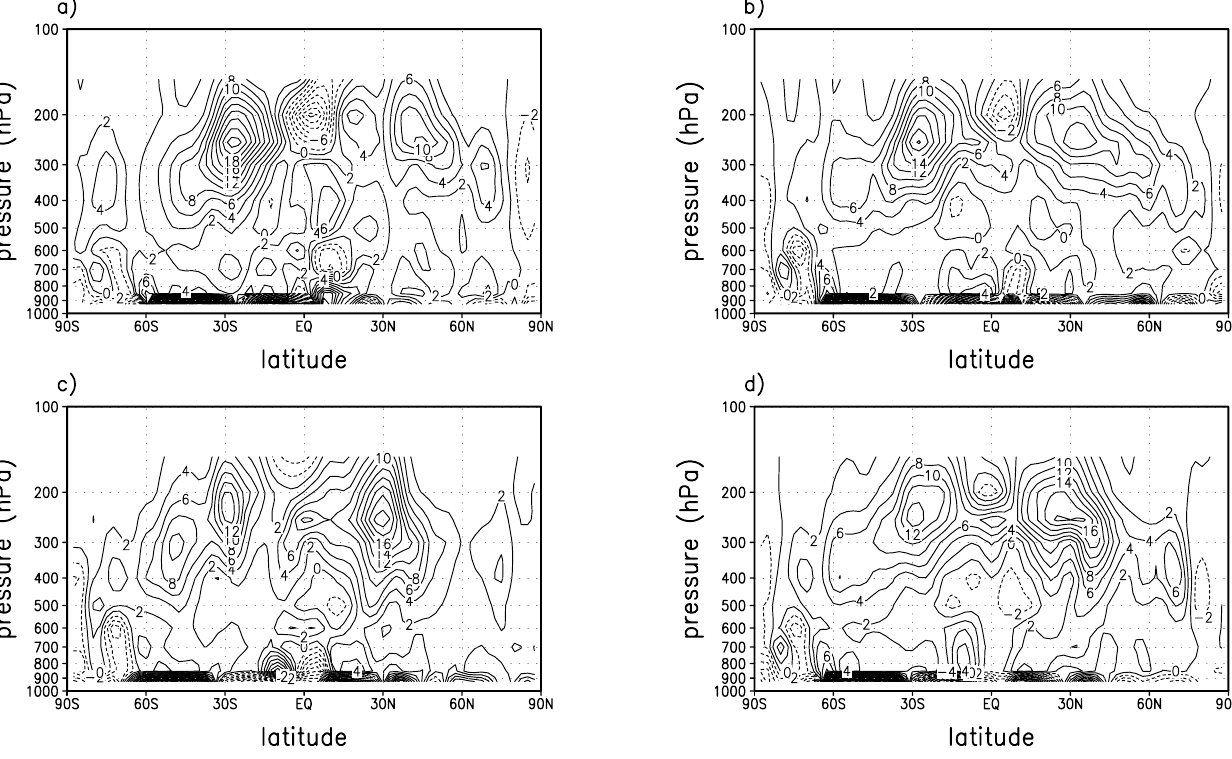
Fig. 3. Zonally-averaged PV gradient for: (a) July 1995, (b) October 1995, (c) January 1996 and (d) April 1996. Units, 10 − 11 m − 1 s − 1 .